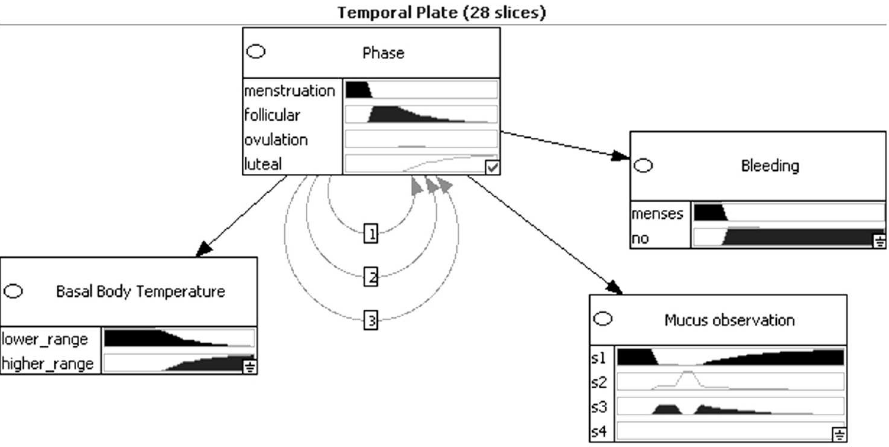
Figure 3. An example of a third-order DBN model of a woman’s monthly cycle. Its temporal influences range from 1 to